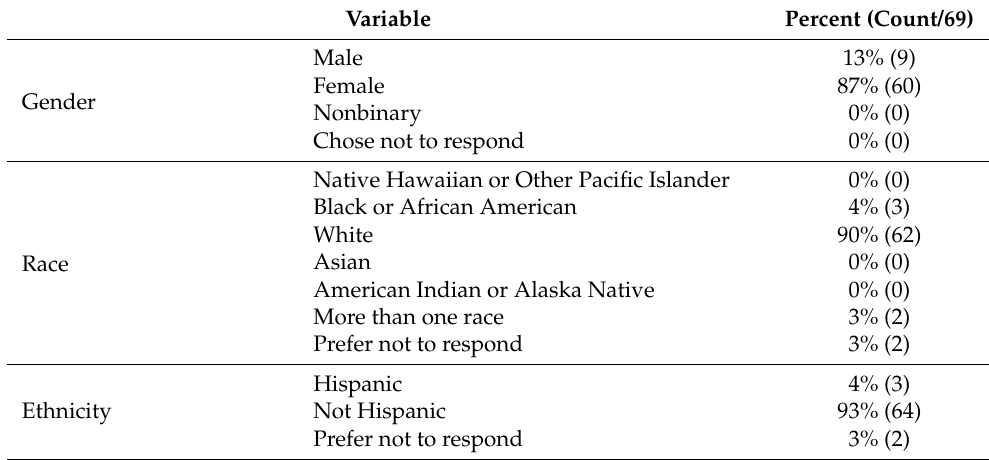
Table 3. Demographics of survey participants, recruited from an Arizona-based nurses association, who had worked in healthcare for at least one year and did not have physician-diagnosed